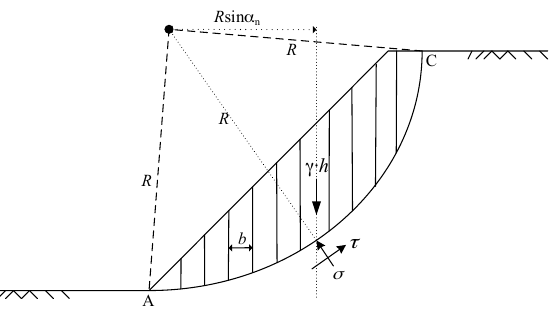
Figure 1. Slope of Bishop slip circle.